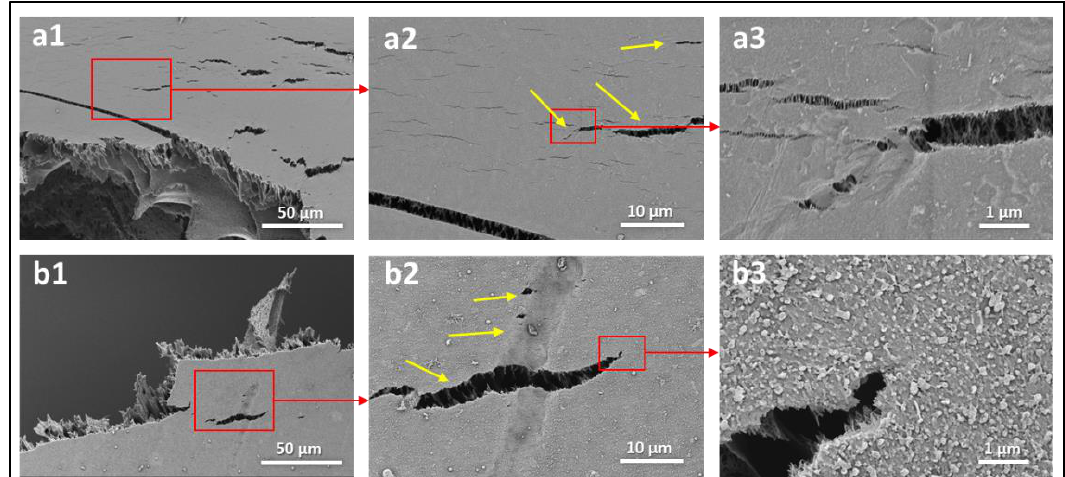
Figure 10. SEM images of the backing-free ( a1 – a3 ) PSF (M2) and ( b1 – b3 ) TFC2-0° membranes tested under dry conditions. The yellow arrows indicate cracks observed in areas close to the fracture region.